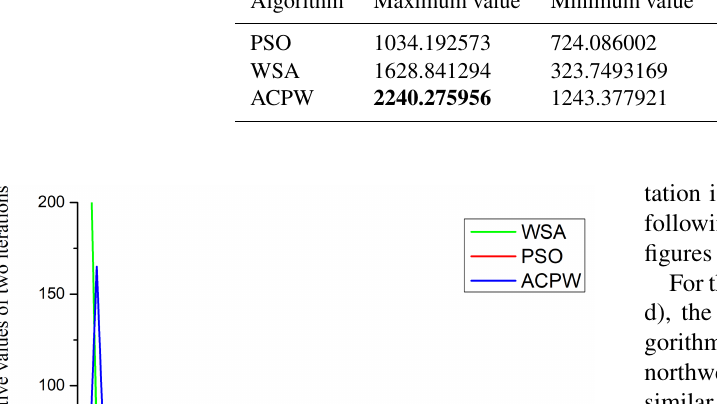
Table 3. The analysis results of the PSO, WSA and ACPW methods. The bold numbers represent the best values. Algorithm